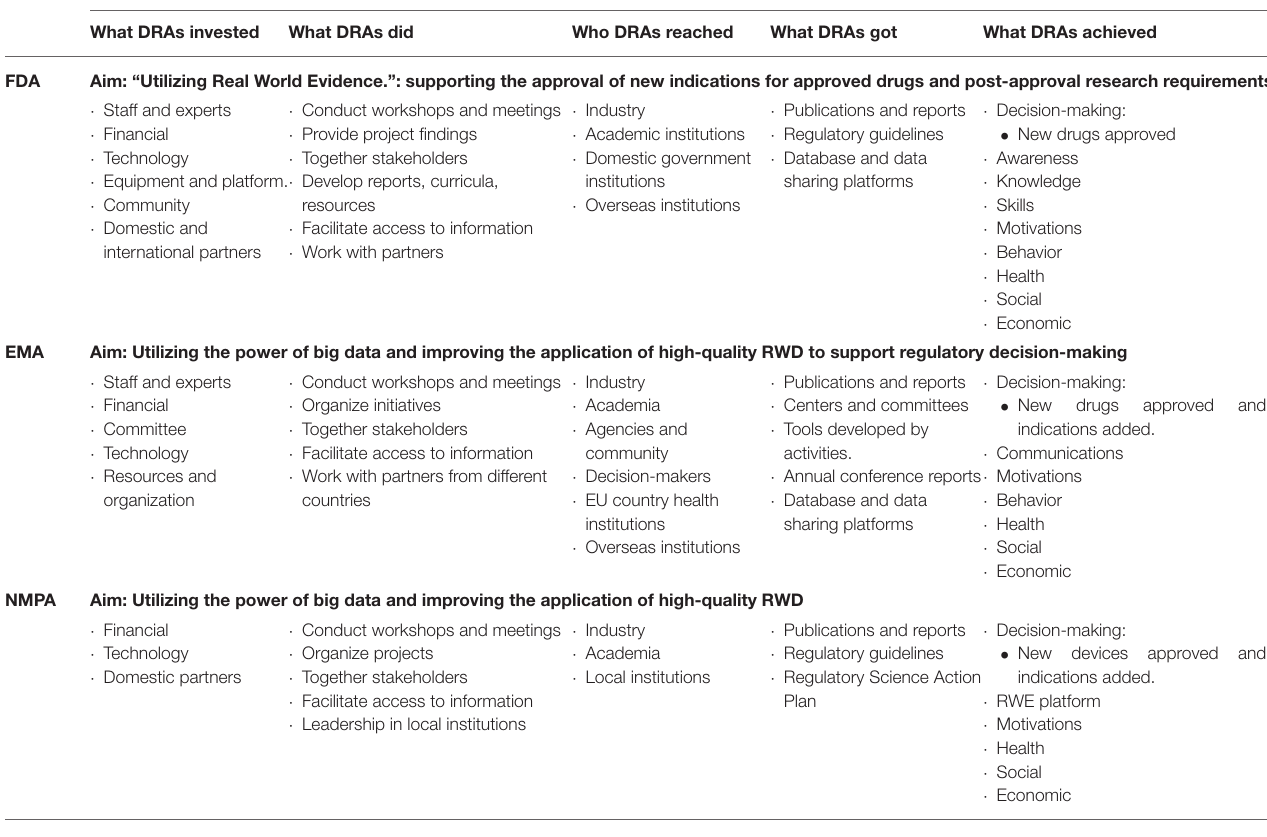
TABLE 2 | Logic model of RWE development in FDA, EMA, and NPMA. DRAs INPUTS ACTIVITIES OUTPUTS OUTCOMES What DRAs invested What DRAs did Who DRAs reached What DRAs got What DRAs achieved